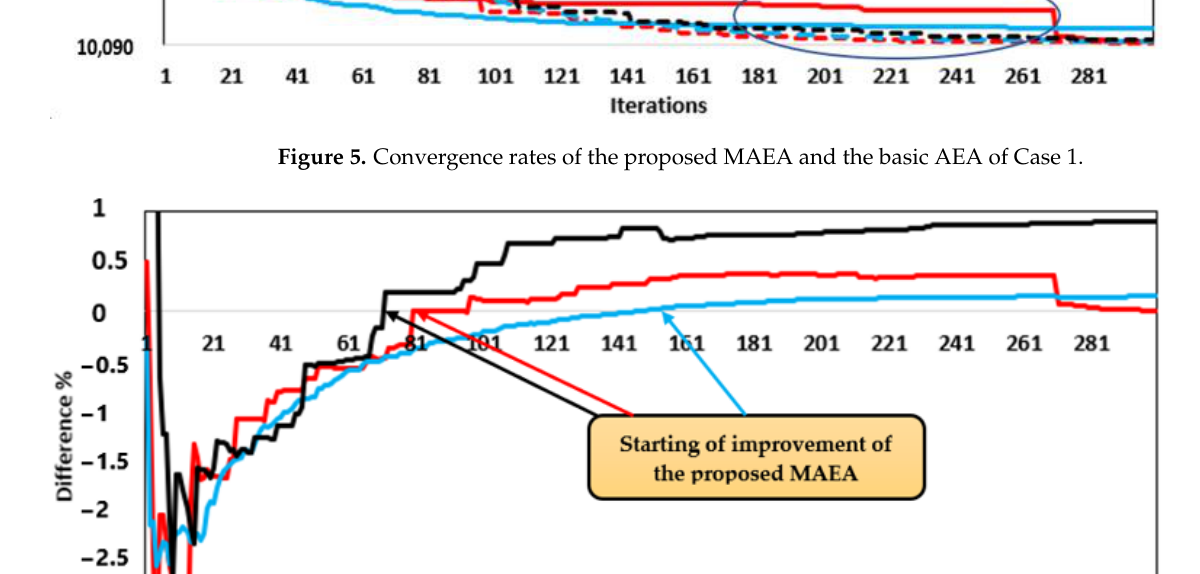
Figure 6. Percentage difference for the best and worst run and the average of all runs of the MAEA and AEA of Case 1.